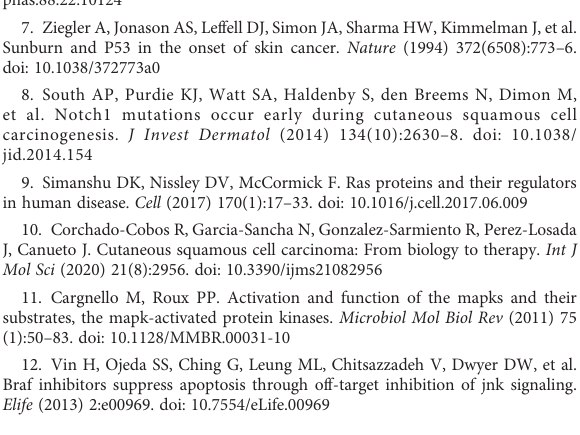
SUPPLEMENTARY FIGURE 1 Thestudydesignidenti fi ed4potentialtargetedgenesafterPDTtreatment regulating MAPK activation and cell cycle in cSCC. SUPPLEMENTARY FIGURE 2 Establishment and validation of diagnosis model by Lasso regression and ROC curve. (A) Coef fi cient pro fi les of 38 cSCC-PDT-related genes. (B) Selection of the optimal lambda in the Lasso model. (C – F) ROC curve of diagnosis model and expression level of above 4 genes. SUPPLEMENTARY FIGURE 3 KEGG pathway map of MAPK signaling pathway (hsa04010, https://www. genome.jp/pathway/hsa04010+1848) SUPPLEMENTARY FIGURE 4 Radar plot of top fi ve single cells with high cell cycle function state after comprehensively ranked by gene expression level and cell cycle function state. (A – D) The single cell set was sequentially sorted by expression levels of CCNL1, DNAJB1, EFNB2 and DUSP6. SUPPLEMENTARY TABLE 1 GO terms annotation of ssGSEA